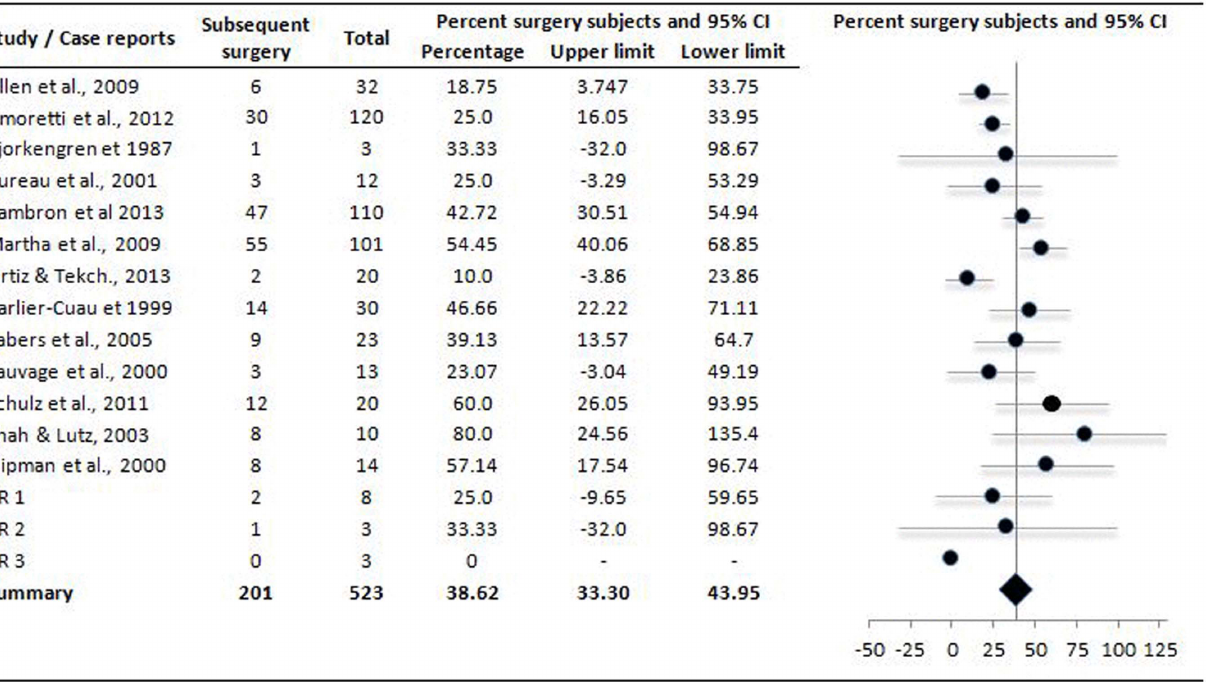
Figure 3. Forest plot showing effect sizes of satisfactory results of percutaneous treatments of the LFJCs after short- or long-term follow-up in individual studies (closed circles) and the overall effect size achieved in meta-analysis (diamond). CR 1 (follow-up 1 mo): Braza et al., 2005; Casselman et al., 1985; Chang, 2009; Foley, 2009; Imai et al., 1998; Kozar & Jeromal, 2014; Lutz and Shen, 2002; Rauchwerger et al., 2011/CR 2 (follow-up 6 month): Boissier et al., 2013; Hong et al., 1995; Shin et al., 2012/CR 3 (follow-up 1 year or more): Gishen et al., 2001; Lim et al., 2001; Lin et al., 2014; Melfi and Aprill, 2005.